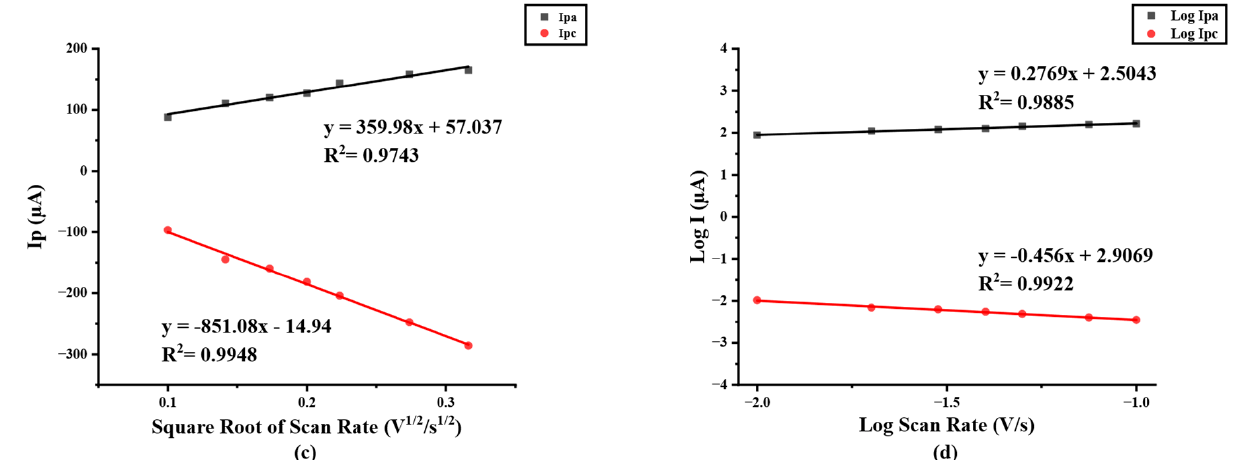
Figure 2. ( a ) Cyclic voltammetry of bare SPIL-GE, modified PB/Ti 3 C 2 T x /SPIL-GE, and PB/Ti 3 C 2 T x /GOx/Nafion/SPIL-GE with 5 mM [Fe(CN) 6 ] 3 − /4 − in 0.1 M KCl, ( b ) Cyclic voltammetry of PB/Ti 3 C 2 T x /SPIL-GE at various scan rates of 10–100 mV/s with 5 mM [Fe(CN) 6 ] 3 − /4 − in 0.1 M KCl, ( c ) Plots of anodic and cathodic peak currents and square root of scan rate for PB/Ti 3 C 2 T x /SPIL-GE and ( d ) Logarithm plots of anodic and cathodic peak currents and logarithm of scan rate.